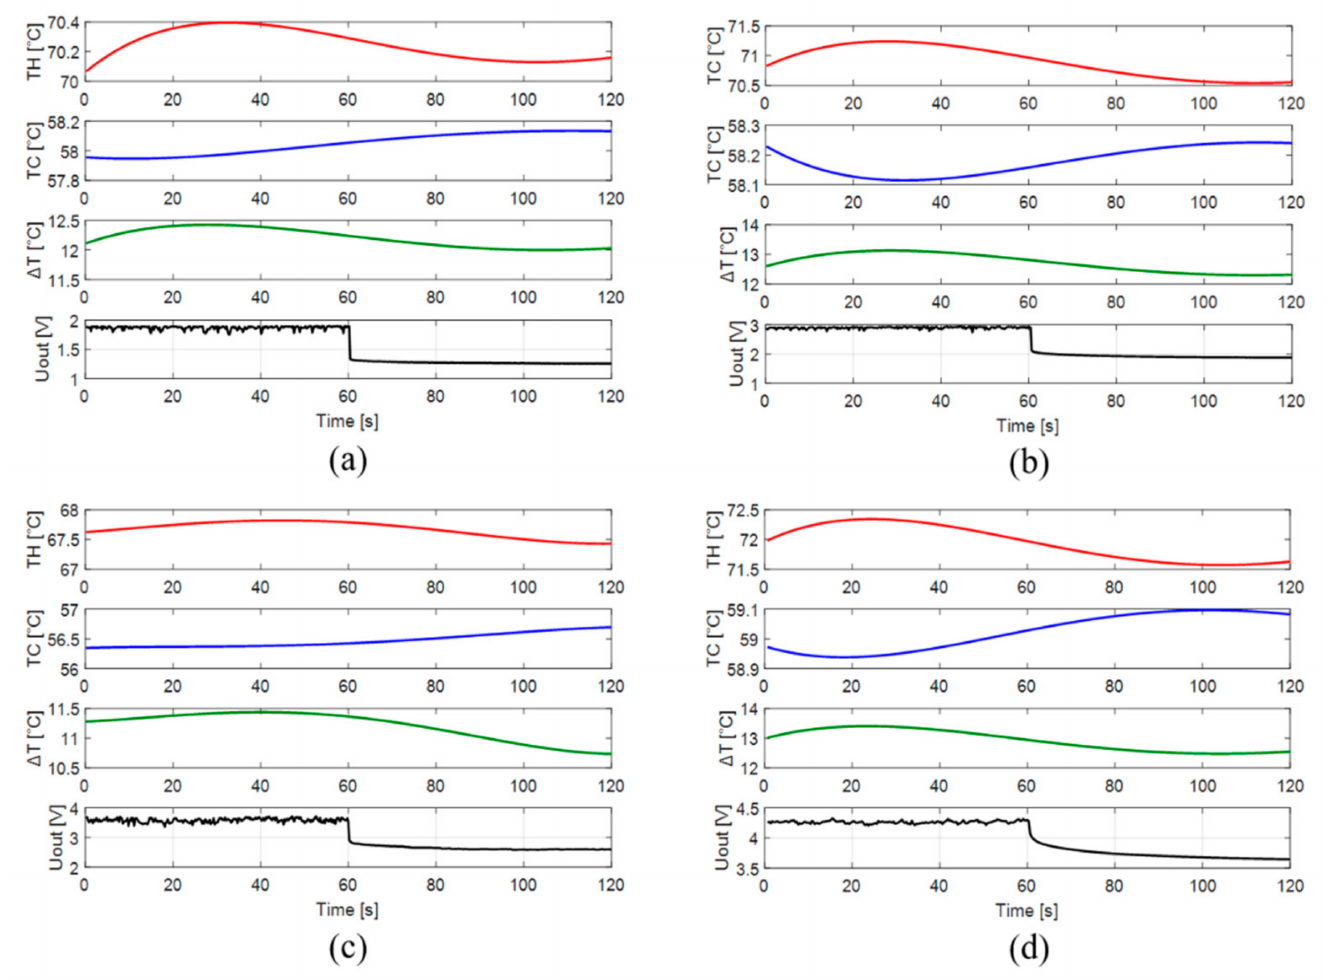
Figure 10. The temperatures and DC/DC converter output voltage curves up to minute obtained with MPPT stopped after 1 min for loads: ( a ) R o = 50 Ω , ( b ) R o = 100 Ω , ( c ) R o = 200 Ω , ( d ) R o = 500 Ω . The measurements (a), . . . , (d) of the above sets of figures were obtained for the resistive loads R o = 50 Ω , R o = 100 Ω , R o = 200 Ω , R o = 500 Ω , respectively. As was